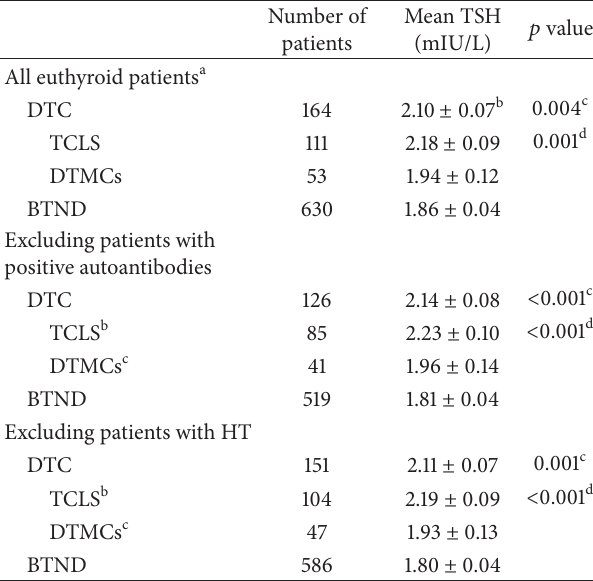
Table 2: Mean preoperative TSH.